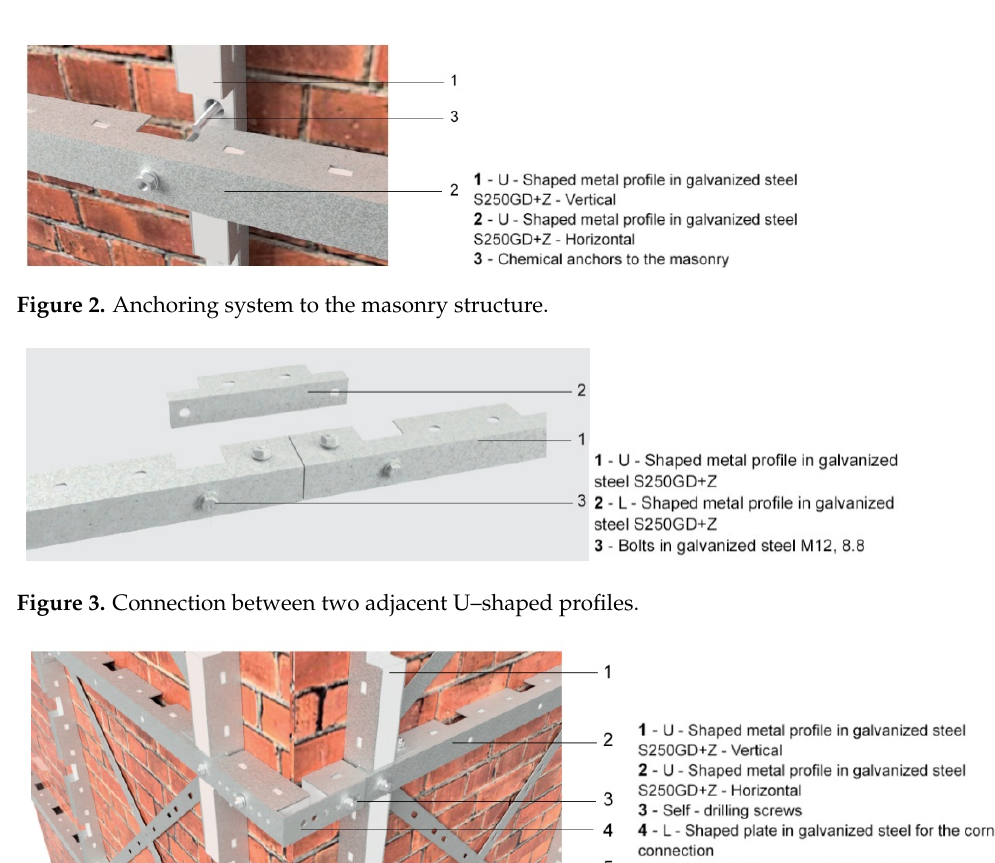
Figure 2. Anchoring system to the masonry structure.